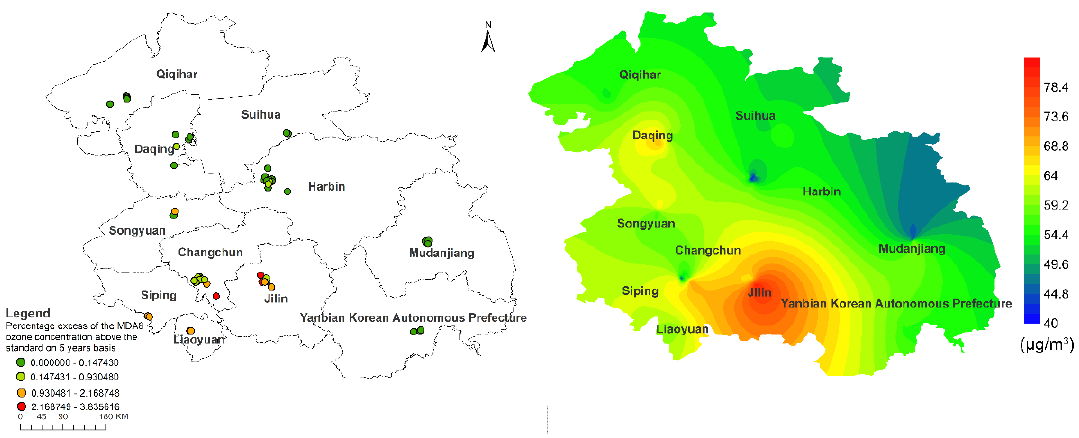
Figure 3. Percentage excess of the MDA8 O 3 concentration above the standard on five-year basis ( left ) and Spatial distribution of five-year average O 3 concentration in HCUA, 2015–2019 ( right ).